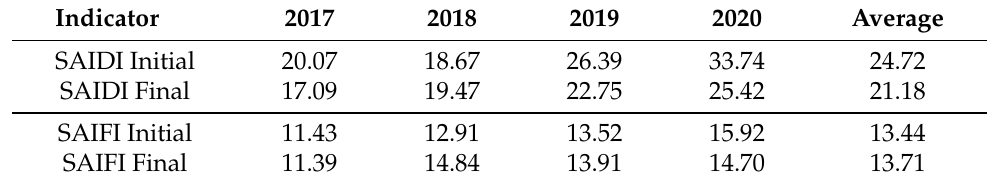
Table 3. Annual SAIDI and SAIFI values for the original configuration and their average values.